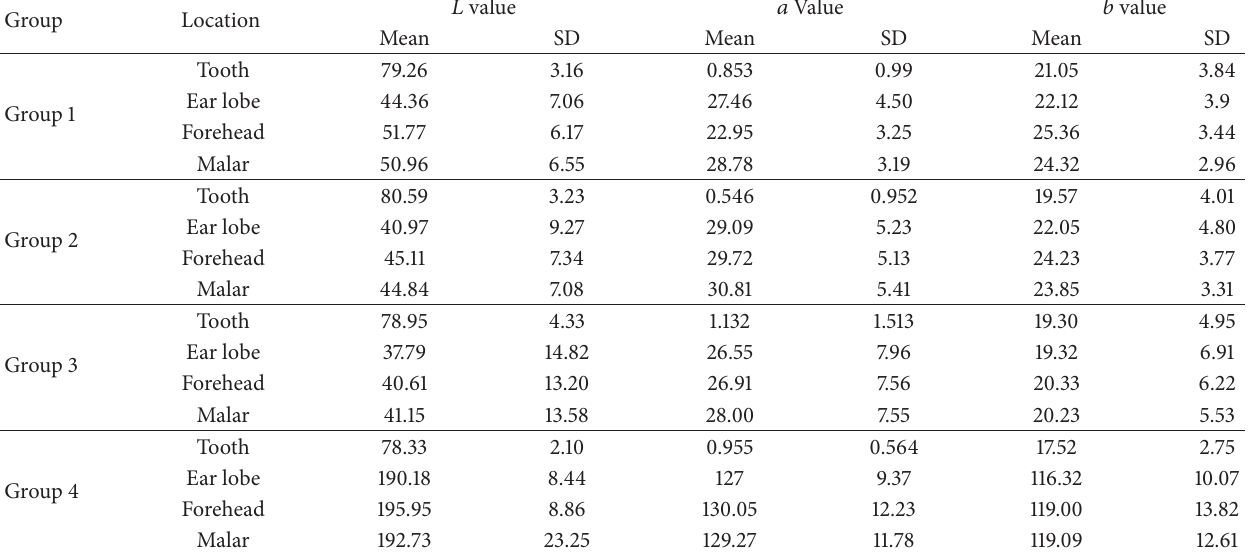
Table 1: Mean 𝐿 , 𝑎 , and 𝑏 values and standard deviation among all ethnic groups. Group